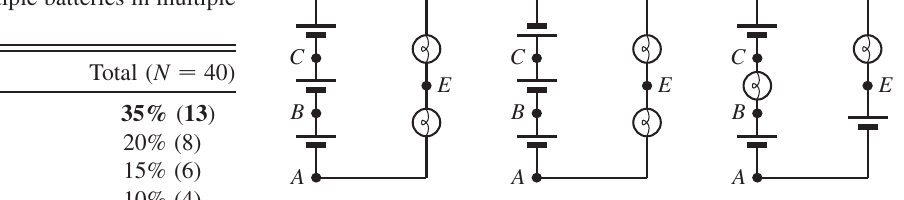
FIG. 6. Circuit diagrams used to develop the idea of potential. Students note the voltages across different elements and the orientation of the voltmeter leads.